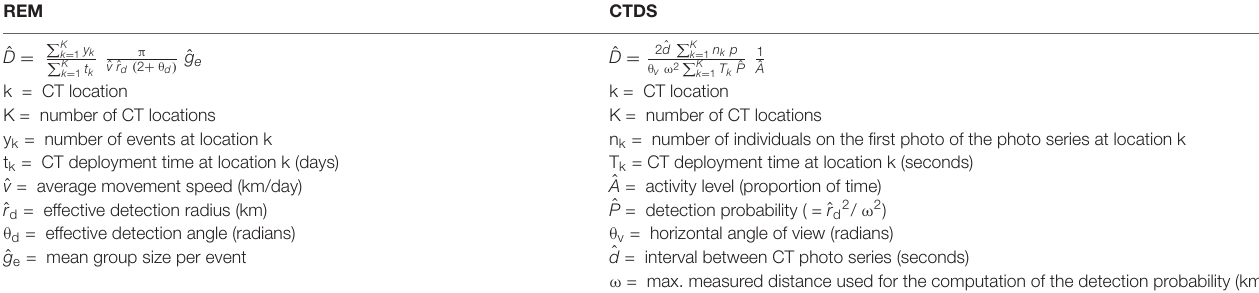
TABLE 1 | Overview of the parameters of the random encounter model (REM) and camera trap distance sampling (CTDS) as adapted for use in this camera trap (CT) study. Parameters accounting for similar influences are shown side by side in the two